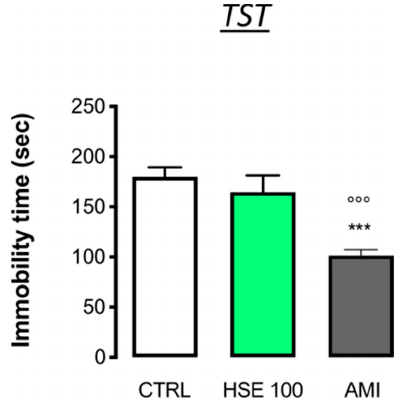
Figure 2. Evaluation of the antidepressant-like activity of Helichrysum stoechas Moench methanolic extract (HSE) in the tail suspension test (TST) compared to amitriptyline (AMI) (one-way ANOVA post-hoc Tukey F (2,12) = 64.05, *** p < 0.001 vs. CTRL, °°° p < 0.001 vs. AMI) The vertical bars represent ± SD ( n = 8).